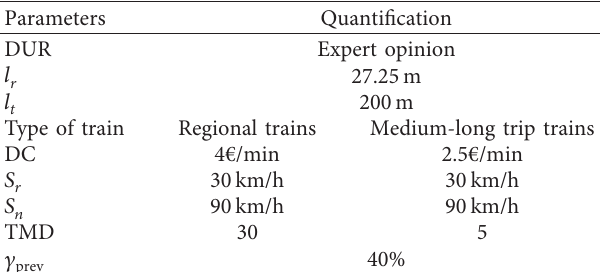
Table 11: Variable quantification for indirect